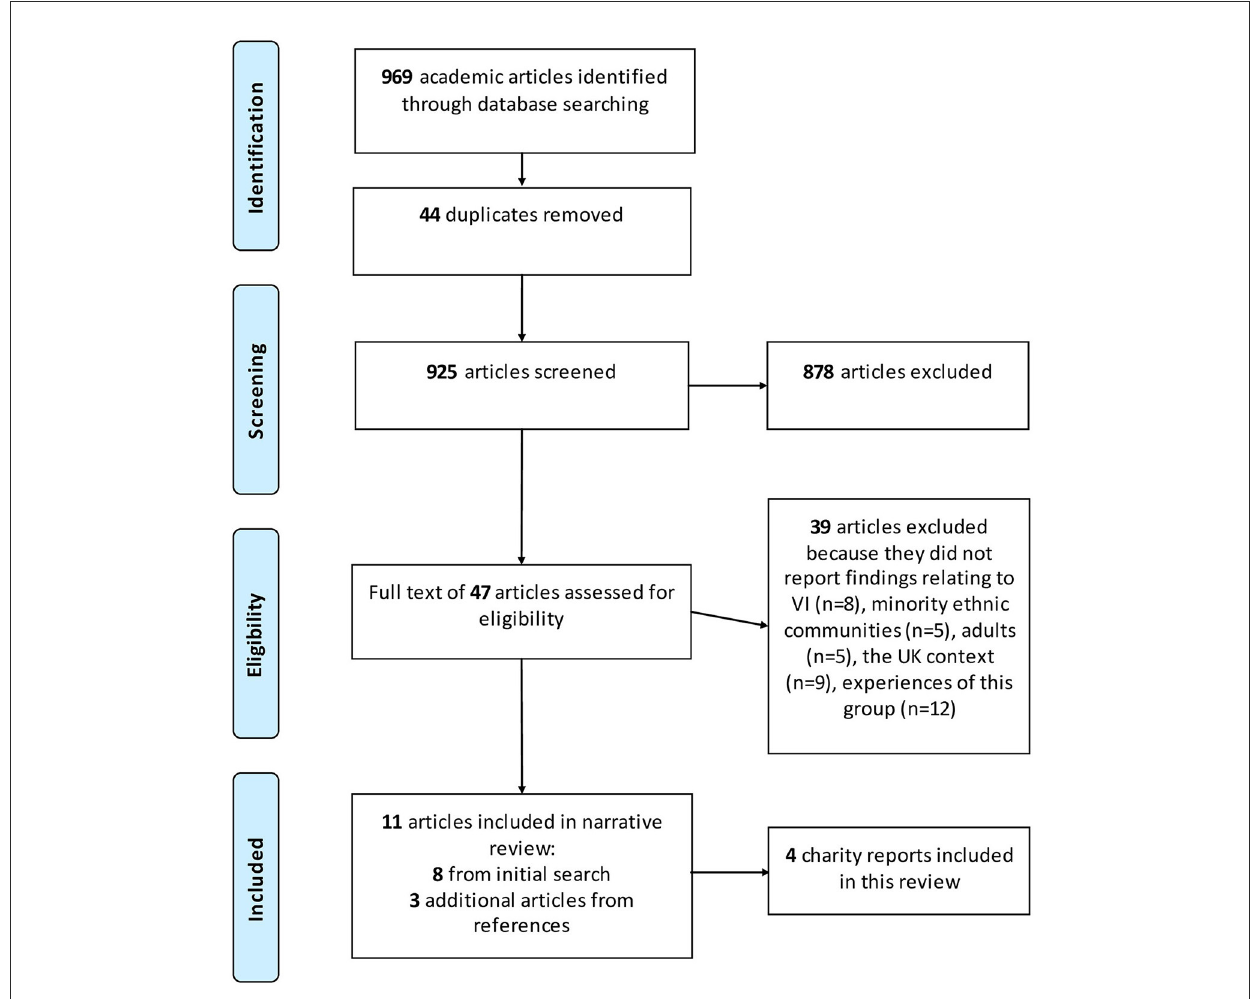
FIGURE2 PRISMA flow